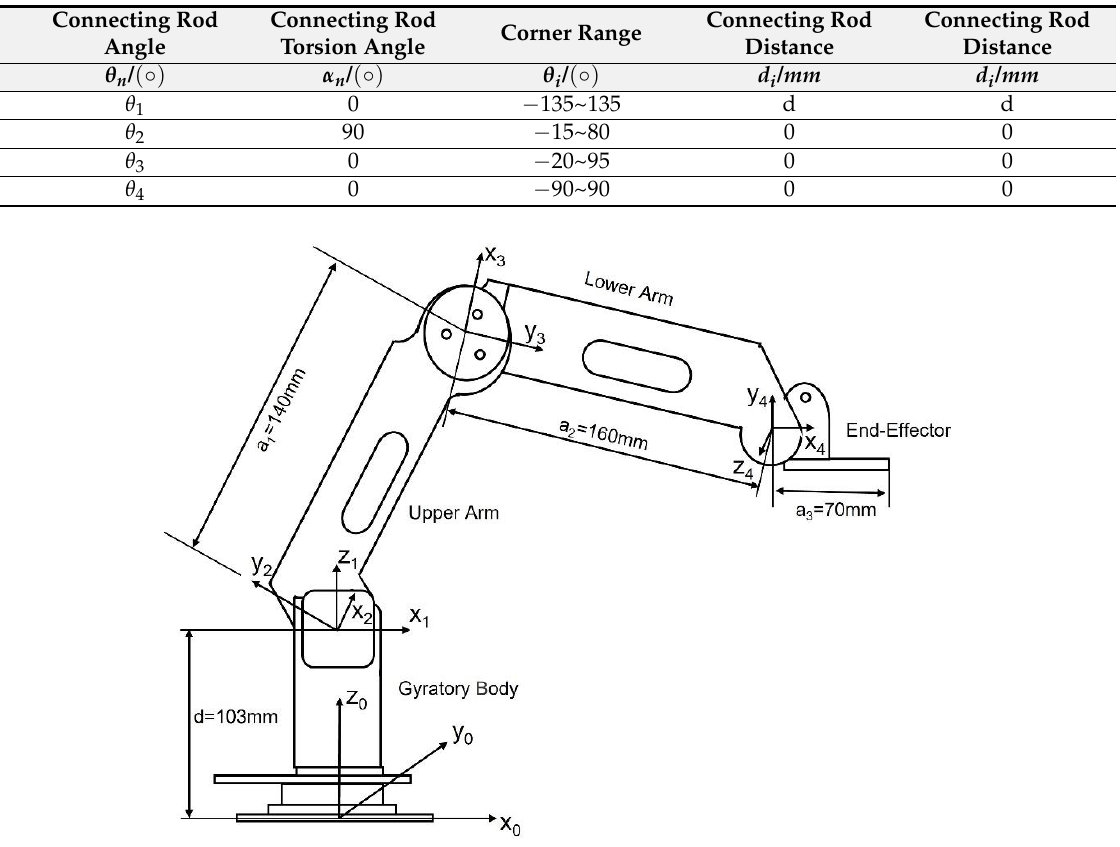
Figure 10. Robot arm link coordinate system. Table 3. Parameters of the experimental manipulator connecting rod. Table 3 is the attached connecting rod D-H parameters, in which the parameters of